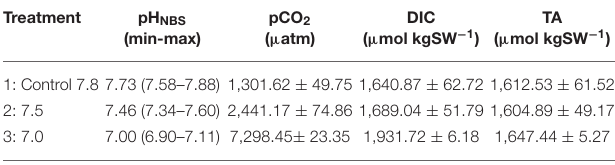
TABLE 3 | Mean p CO 2 , Dissolved Inorganic Carbon (DIC)* and Total Alkalinity (TA) per treatment.